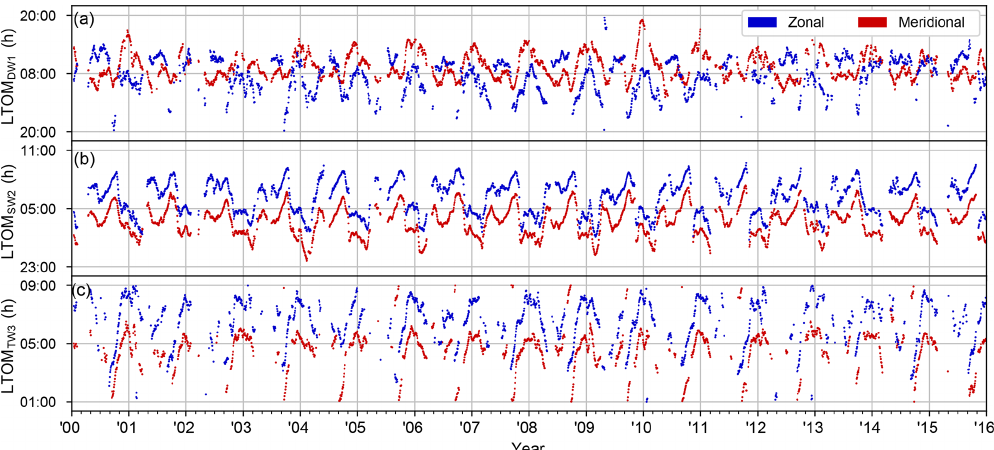
Figure 3. Phase of DW1 (a) , SW2 (b) , and TW3 (c) in SuperDARN zonal (red) and meridional (blue) meteor winds between the years 2000 and 2016. Phases are plotted as the local time of maximum (LTOM). Only phases for when tidal amplitudes are greater than 1.5ms − 1 are shown for